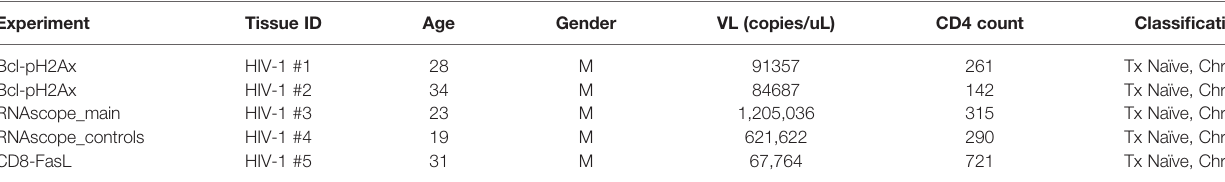
TABLE 2 | Demographic and clinical details of study